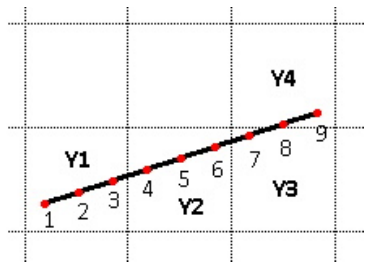
Figure 10. Calculation of the elevations with Nearest Neighbor technique.